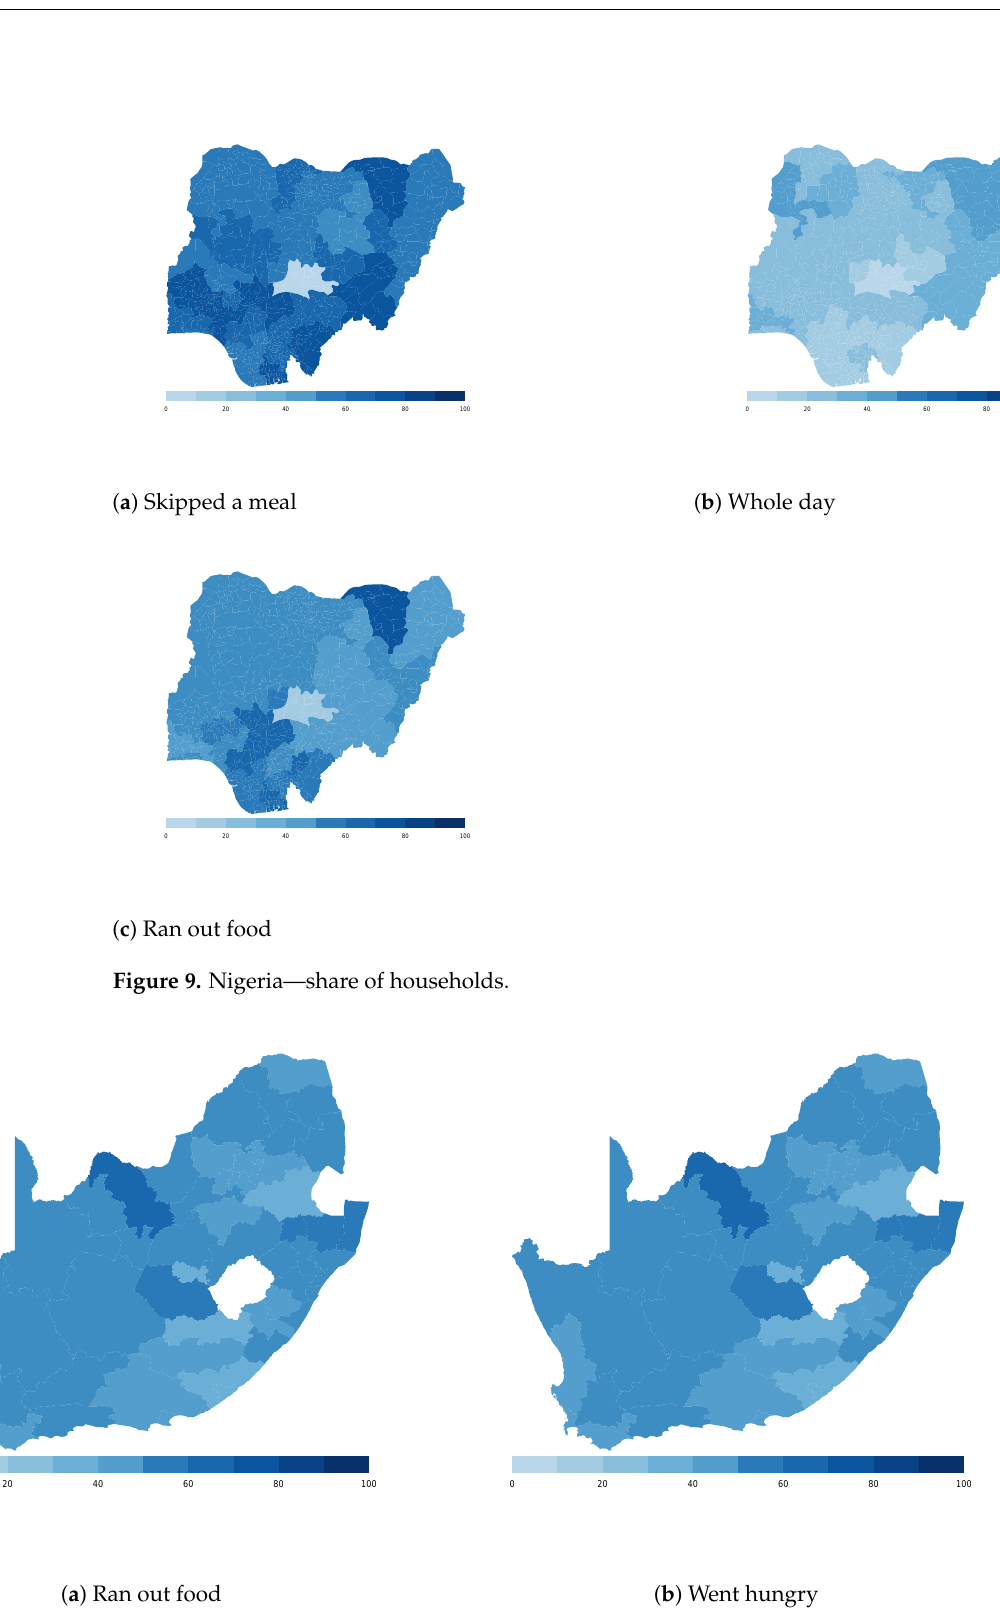
Figure 10. South Africa—share of